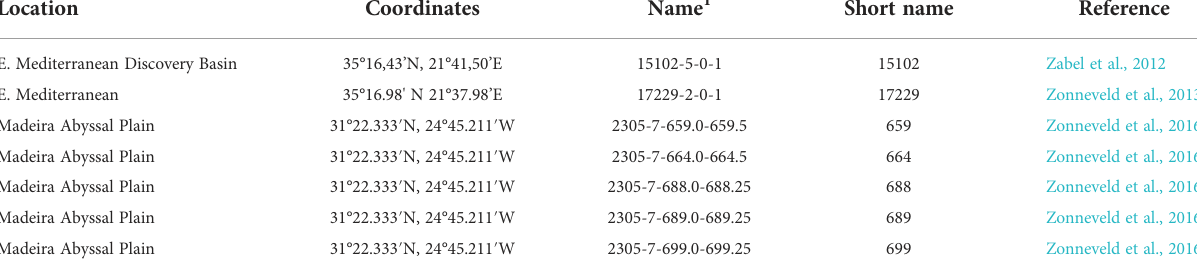
TABLE 1 Gravity core samples